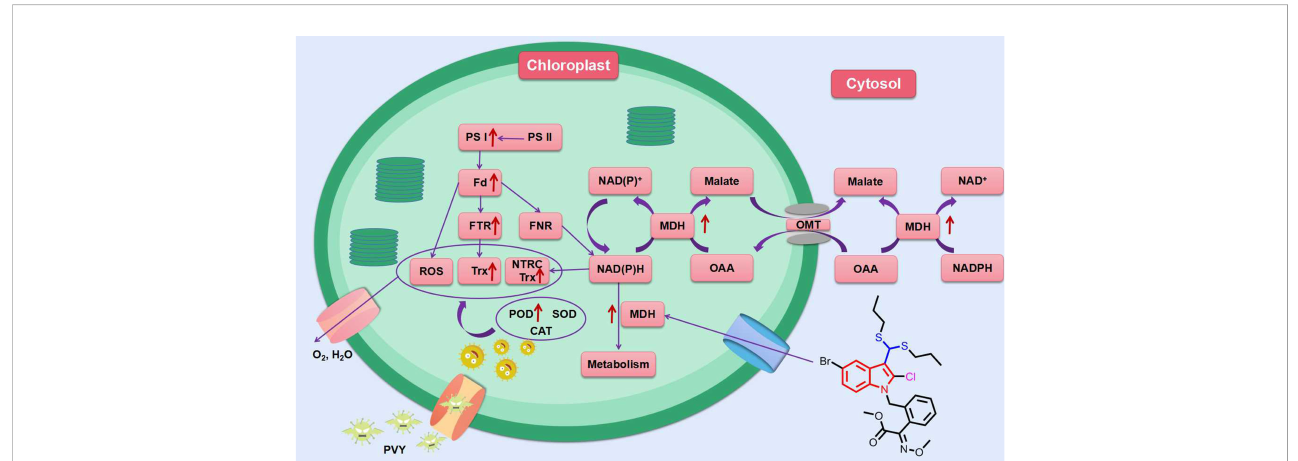
FIGURE 7 MDH signaling pathway in tobacco response to compound 28. Red arrows indicate that the protein is upregulated in this pathway. (Fd, ferredoxin; FNR, ferredoxin-NADP reductase; FTR, ferredoxin-thioredoxin reductase; MDH, malate dehydrogenase; NTRC, chloroplast NADPH-thioredoxin reductase; OAA, oxaloacetate; OMT, malate/OAA translocators; PS I, photosystem I; PS II, photosystem I; ROS, reactive oxygen species; Trx, thioredoxin). (Wei et al.,